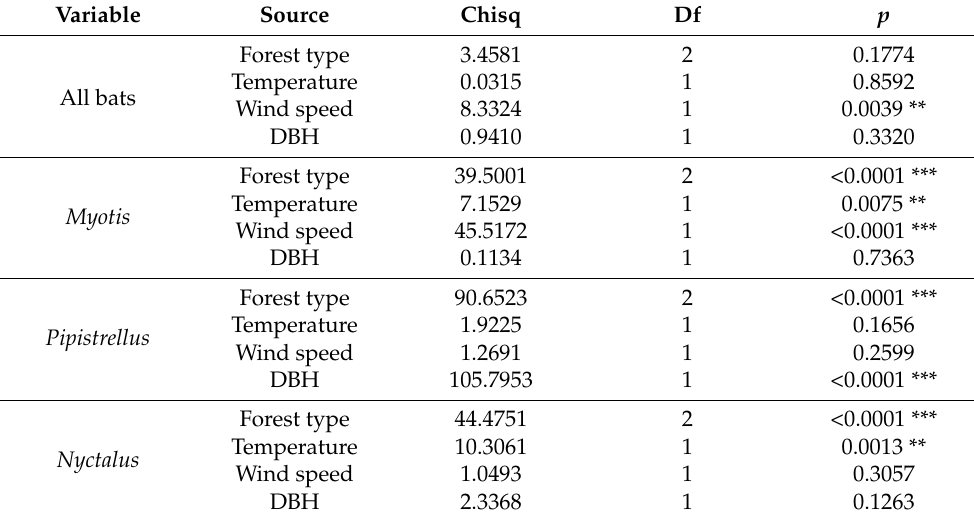
Table 4. Outcome of analyses of deviance after computation of generalized linear mix models (GLMM) of bat passes for all bat species together and three genera of bats ( Myotis , Pipistrellus , and Nyctalus ) separately.